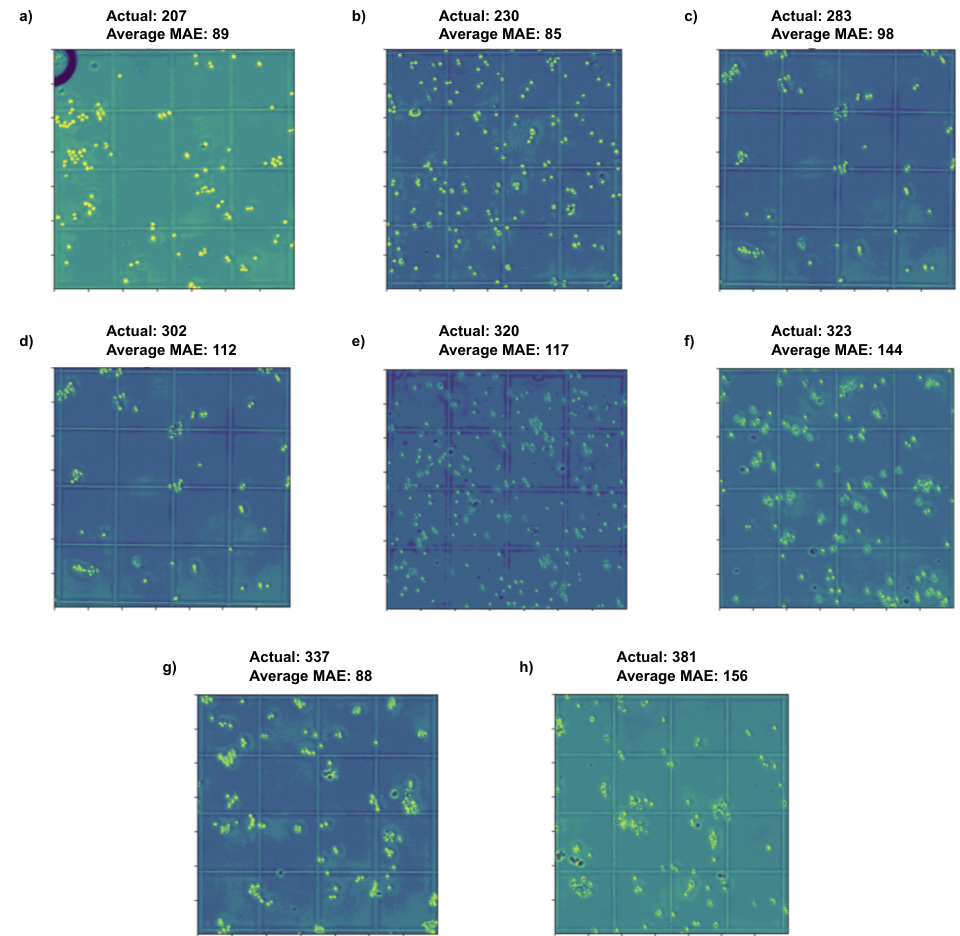
Figure 8. Subplots showing the eight images with the highest cell count. These were also the images that both models performed worst